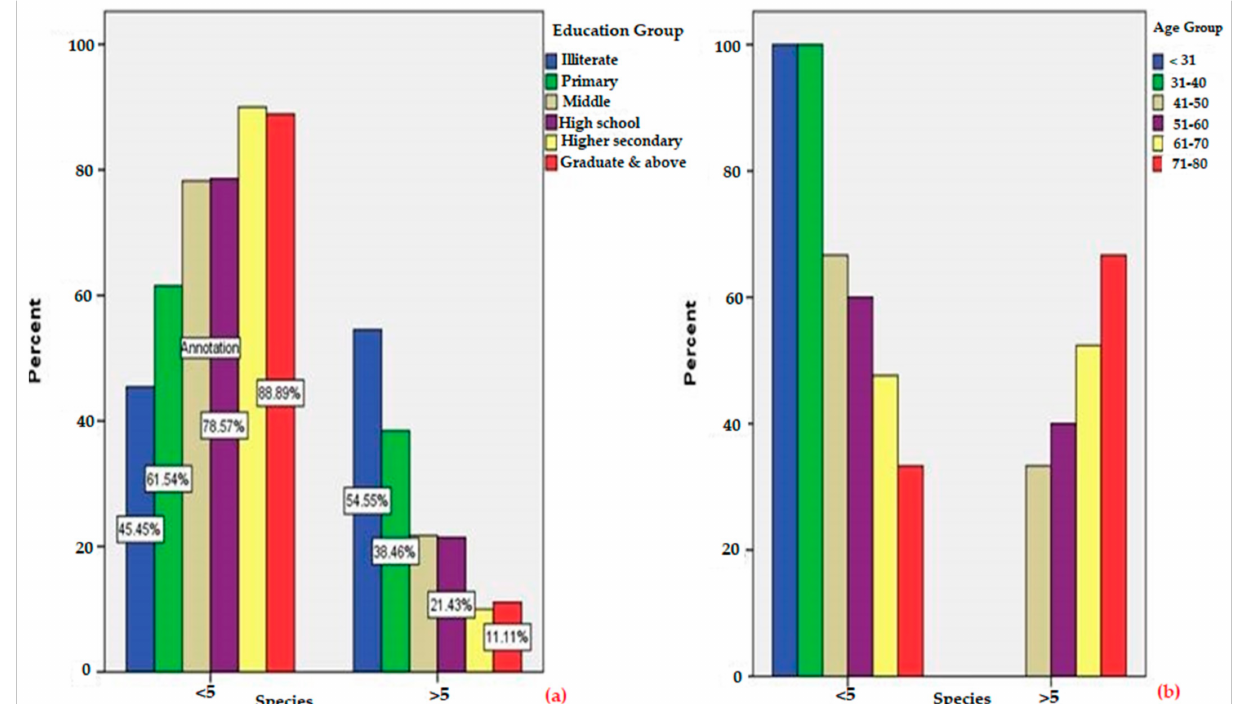
Figure 4. Graphical representation of the relationship between ( a ) education level ( χ 2 (5) = 13.734, p = 0.017 (<0.05)) and ( b ) age group ( χ 2 (5) = 25.673, p = 0.001 (<0.05) and knowledge of medicinal plants. Table 2. Chi-square test value table showing the relationship between knowledge of medicinal plants and the demographic characteristics of informants (gender, place, community and age category).